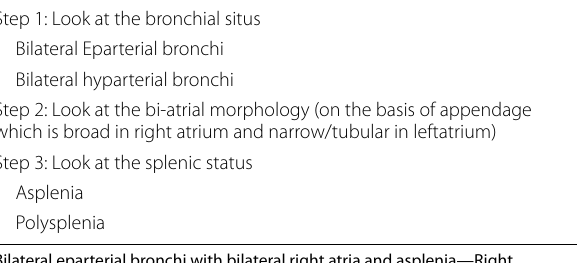
Table 1 Methodological approach for determination of type